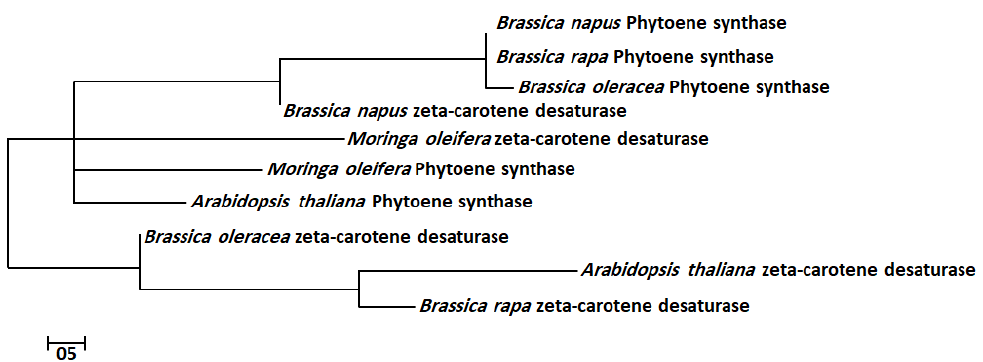
Figure 1. Molecular phylogenetic analysis of ZDS and PSY bioactive genes by maximum likelihood method. The evolutionary history of ZDS and PSY bioactive genes was inferred by using the maxi- mum likelihood method with 1000 bootstraps based on the Tamura – Nei model.